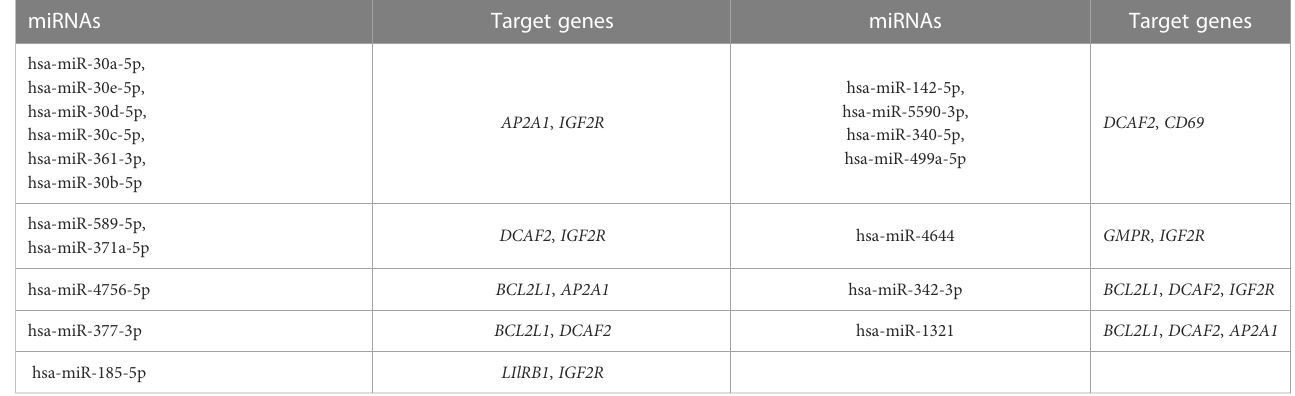
TABLE 4 The candidate miRNAs that regulate multiple target genes in the miRNA-hub genes network.